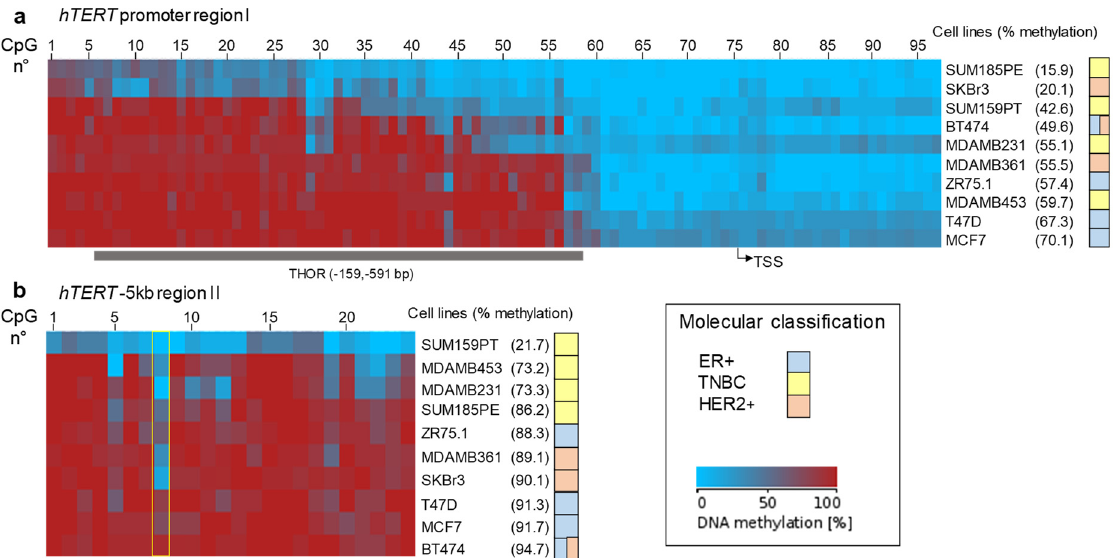
Figure 3. Condensed graphical representation of TERT methylation patterns in breast cancer cell lines. ( a ) hTERT promoter (region I). ( b ) hTERT − 5 kb region upstream the TSS (region II). The methylation patterns were created using BDPC compilation software: columns represent CpG sites, while rows represent the average methylation profile of each PCR product for each cell line. The average level of CpG methylation is indicated in brackets. In ( a ) , the position of THOR between − 159 and − 591 bp from the TSS is shown. In ( b ), the position of the remarkable CpG (CpG 8 , chr5: 1,300,438) is pointed out. THOR: TERT hypermethylated oncologic region. TSS: transcription start site.